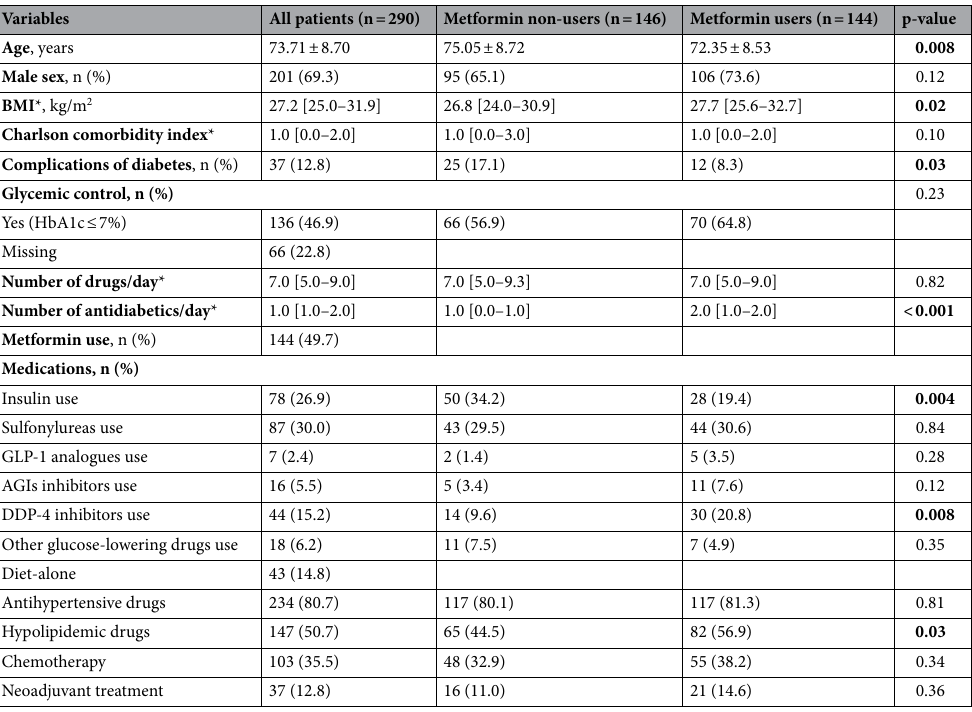
Table 1. Main characteristics of CRC patients with type 2 diabetes mellitus compared by metformin status. Significant values are in bold. *Indicates variables that are not normally distributed. Quantitative variables are reported as mean ± SD or median